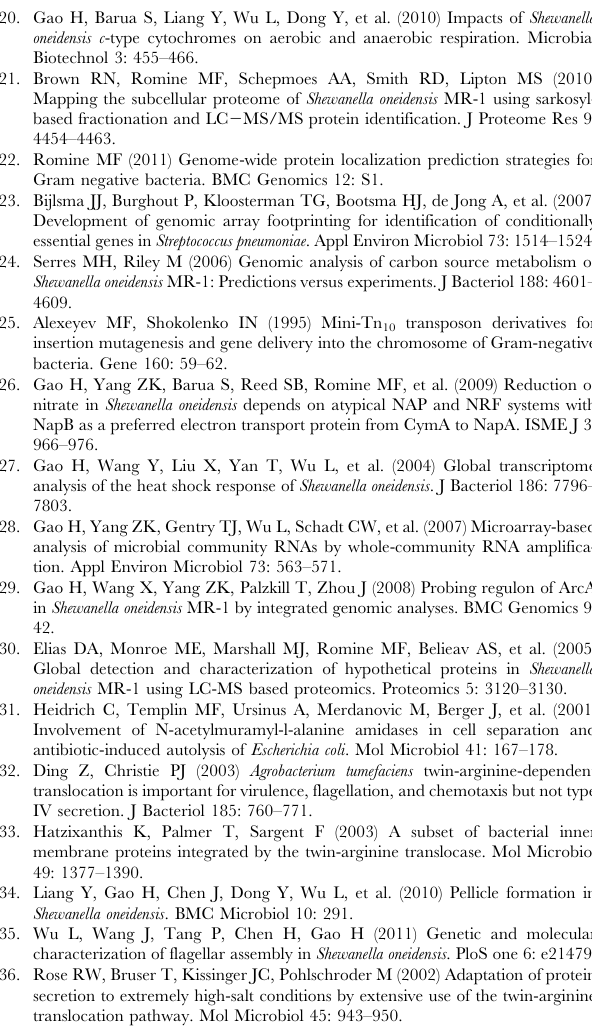
Figure S1 Comparative analysis of phenotypes of S.